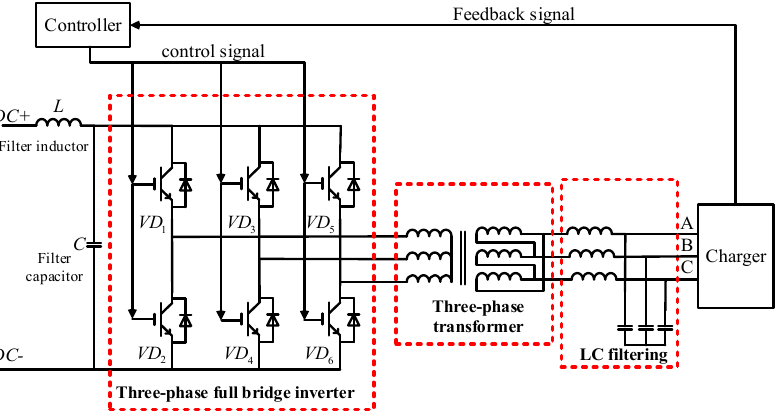
Figure 3. Basic topology of China Standard EMU auxiliary converter.